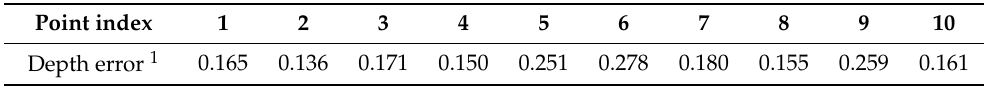
Table 2. Statistics for average distance deviations and standard deviations of global point clouds after optimization of registration.